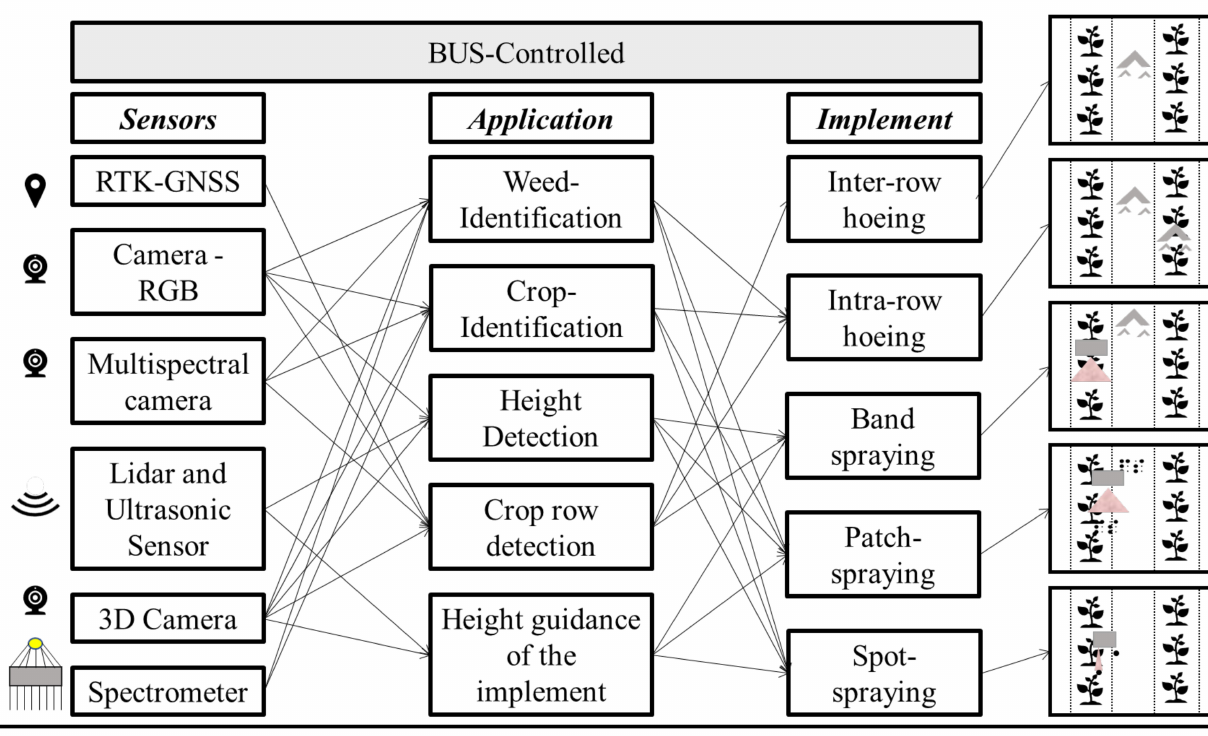
Figure 5. Overview of sensors with suitable icons, application and implementation options with drafts of the working methods, that should be possible to be controlled via